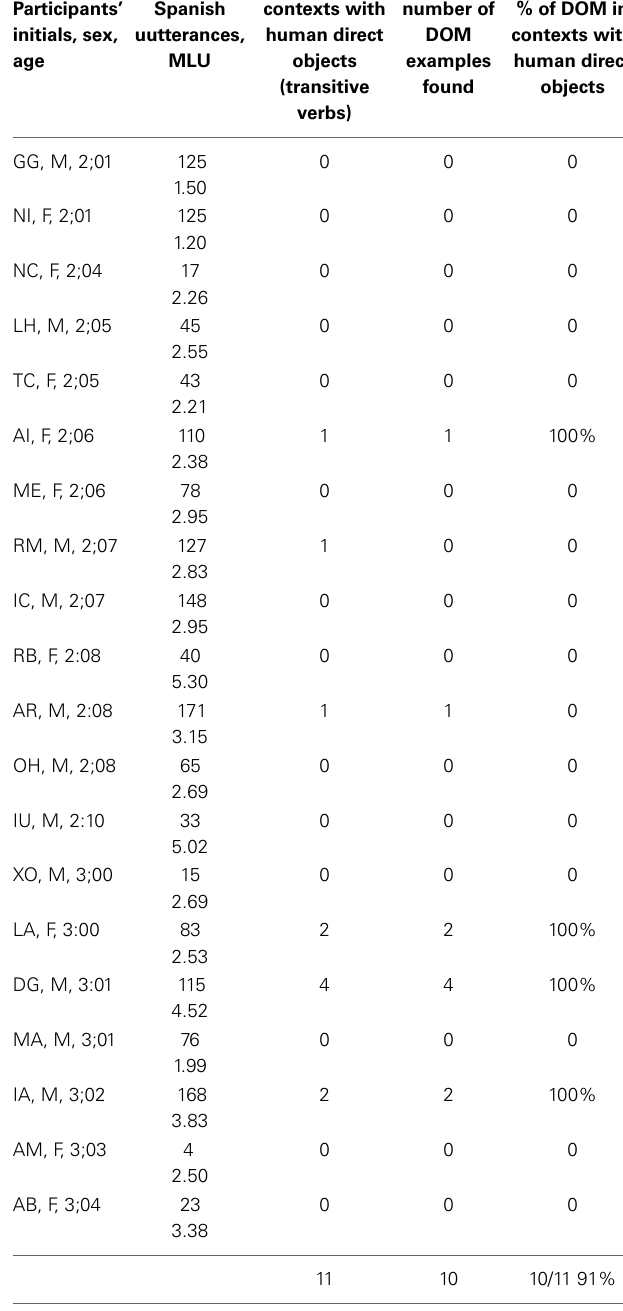
Table 8 | Verbs used with DOM by bilingual children. Verbs used with DOM